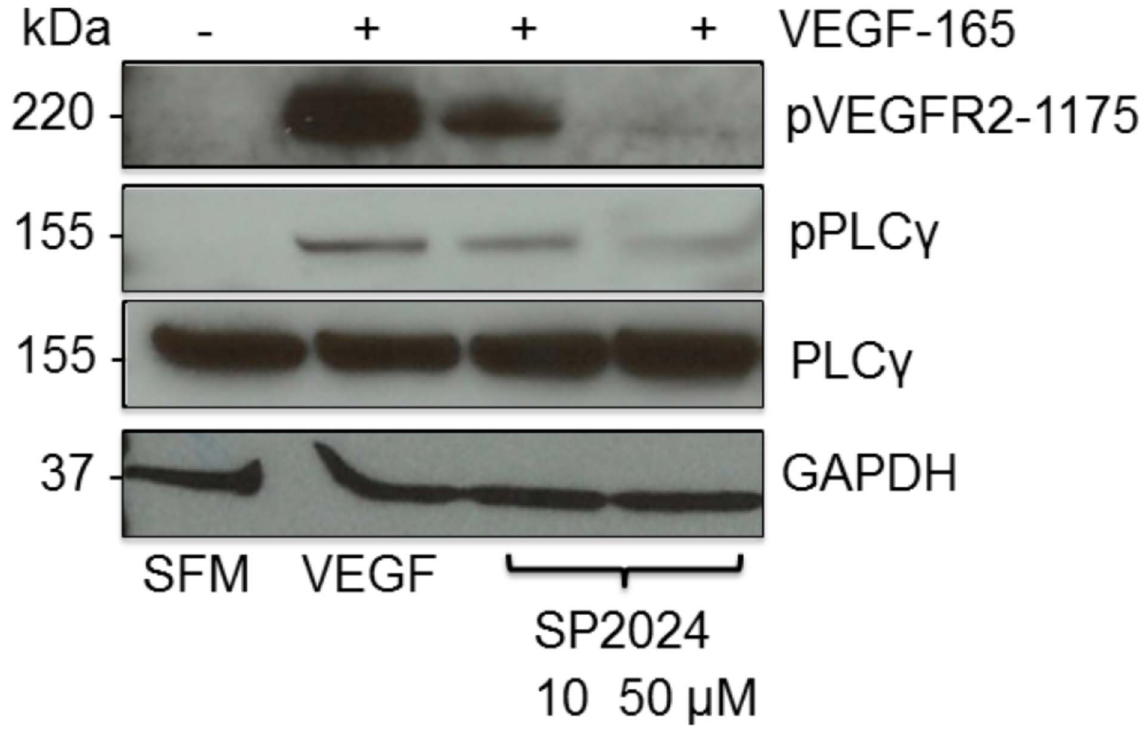
Figure 3. Inhibition of the phosphorylation of signaling proteins of the VEGFR2 pathway. Western blot analysis of the effect of the peptide treatment of HUVEC cells on the phosphorylation of VEGFR2 and PLC c . The first column represents the base level of proteins expression in the presence of serum free media (SFM), the second column shows the levels of the proteins when cells are treated with VEGF (20 ng/ml) and the next two columns show the decrease in the levels of the proteins in cells exposed to VEGF (20 ng/ml) and 10 or 50 m M of SP2024. GAPDH was used as